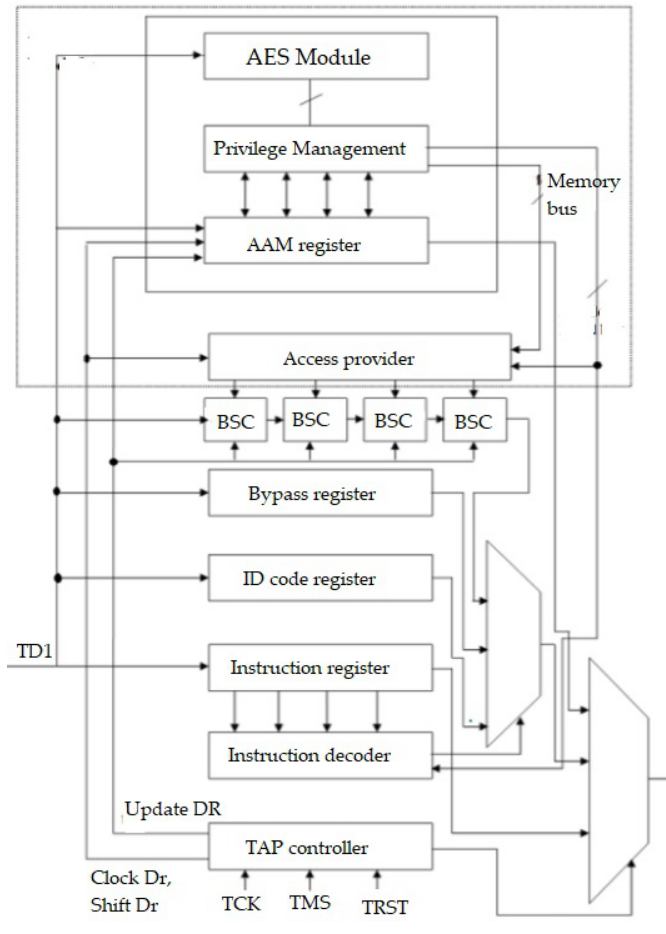
Figure 4. Secure JTAG architecture